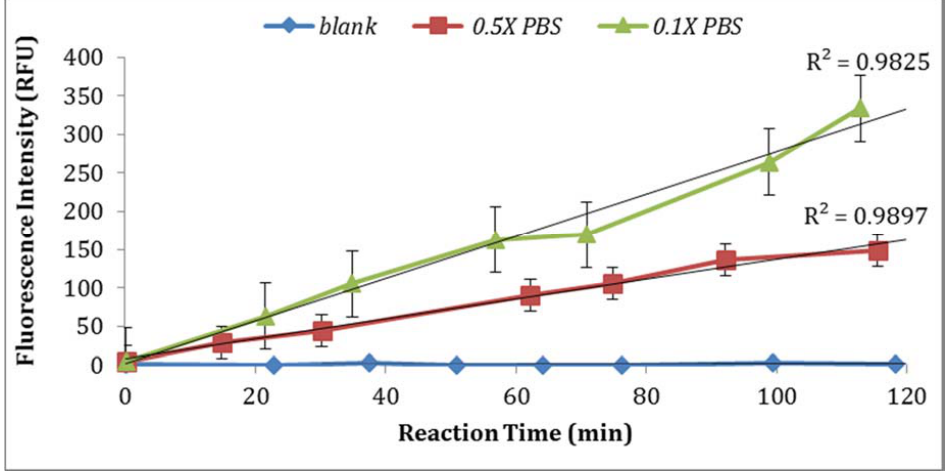
Figure 5. Impact of buffer strength on fluorescence intensity.